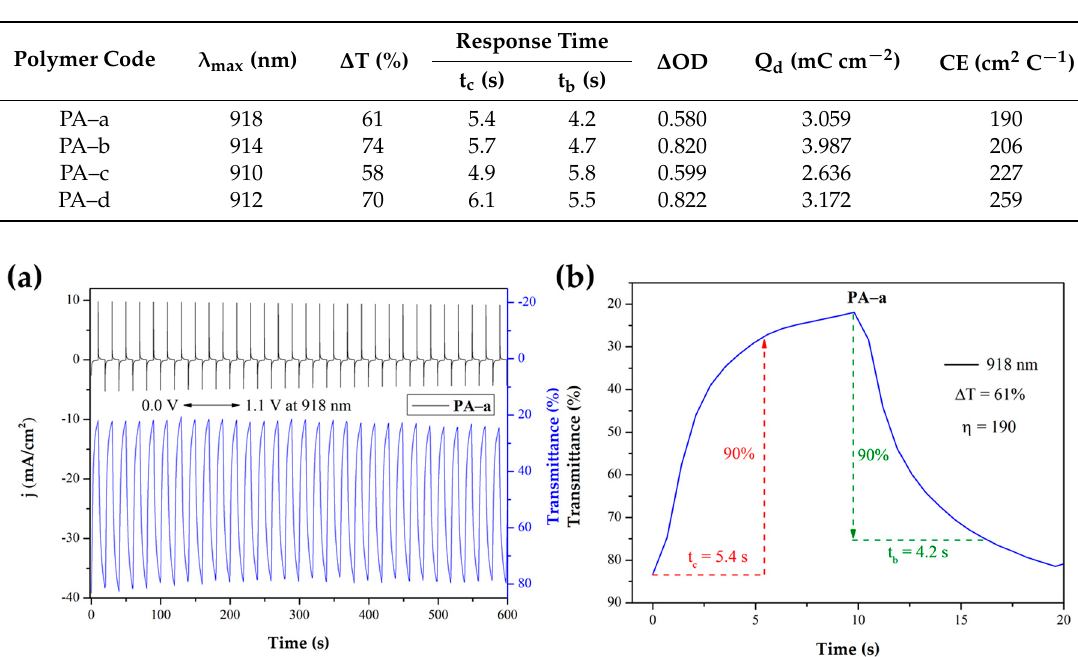
Table 4. Electrochromic properties of PAs.